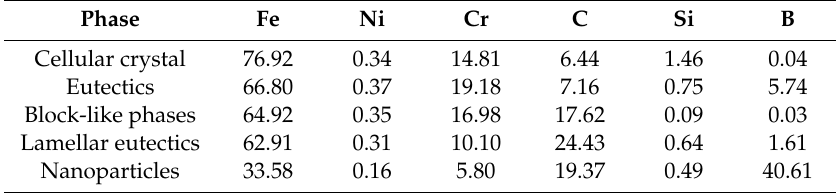
Table 3. Chemical composition of di ff erent phases examined by EDS (at.%).